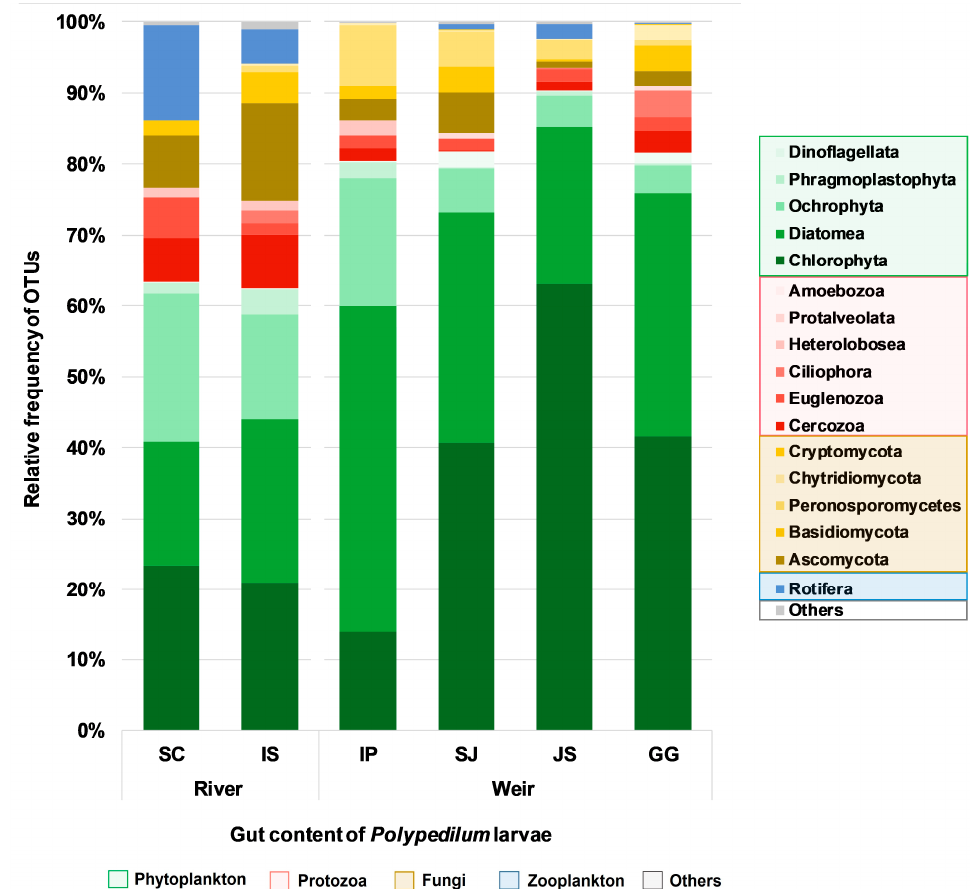
Figure 2. Relative OTU frequency of V9 18S rRNA sequence reads at phylum level showing major diet composition in the gut of chironomid. Unique/rare taxa comprising minor OTUs such as Annel- ida, Arthropoda, Cnidaria, Marine Stramenophiles, Mollusca, Nematozoa, Nucleariidae/Fon- ticula, Vertebrata, Neocallimastigomycota, Haptophyta (Prymnesiophyceae), Cryptophyta (Cryp- tophyceae) grouped as Others. Table 2. Operational taxonomic units (OTUs), Good’s coverage, Chao1 (S), and niche breadth (B A ) estimated for the diet composition of chironomid.